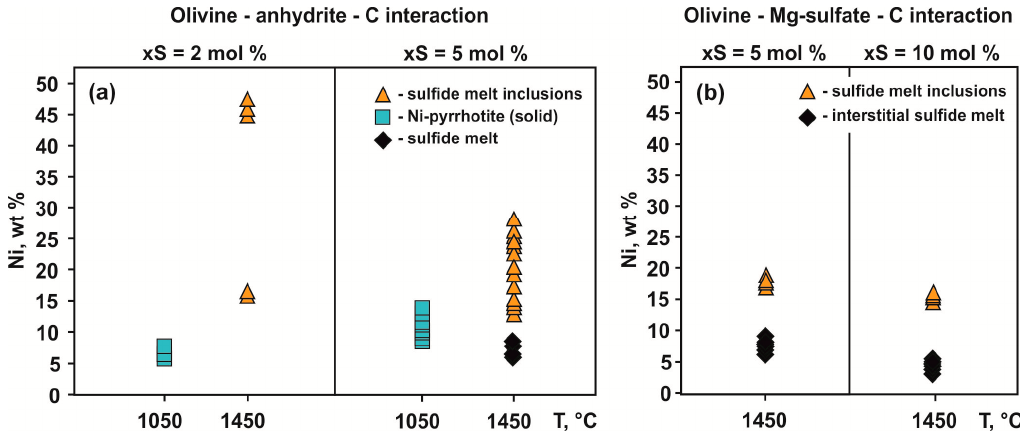
Figure 5. Temperature and sulfur content (xS) dependencies of Ni concentrations in sulfides and sulfide melts.